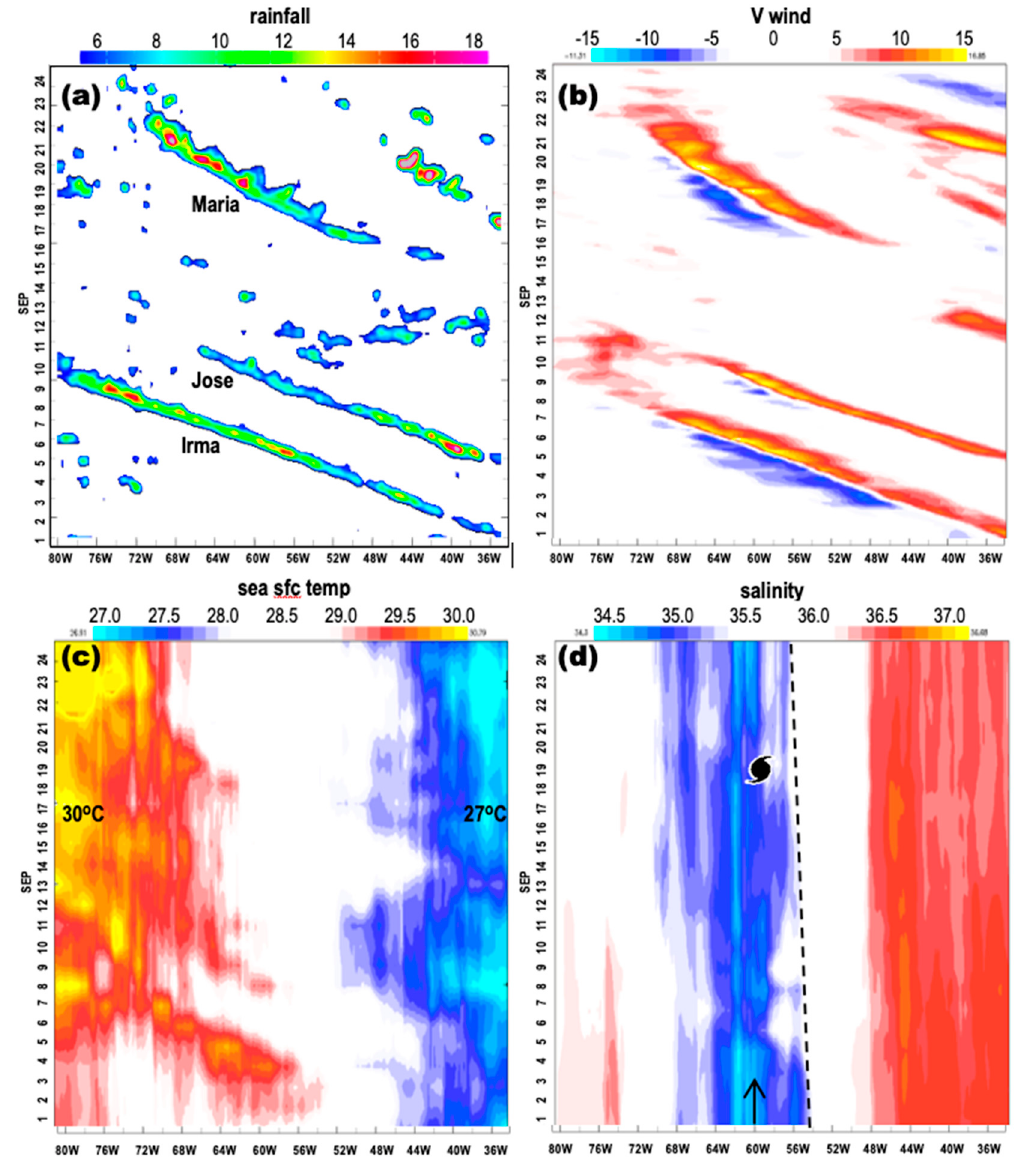
Figure 1. Hovmoller plots 1–25 September 2017 averaged 12–18N of: ( a ) CMORPH rainfall (mm/hr), ( b ) 850 hPa meridional wind (m/s), ( c ) HYCOM sea surface temperature (SST; °C), and ( d ) surface salinity (ppt). In (d): Dominica longitude (arrow), edge of low salinity zone (dashed), and hurricane Maria (icon); time goes up.